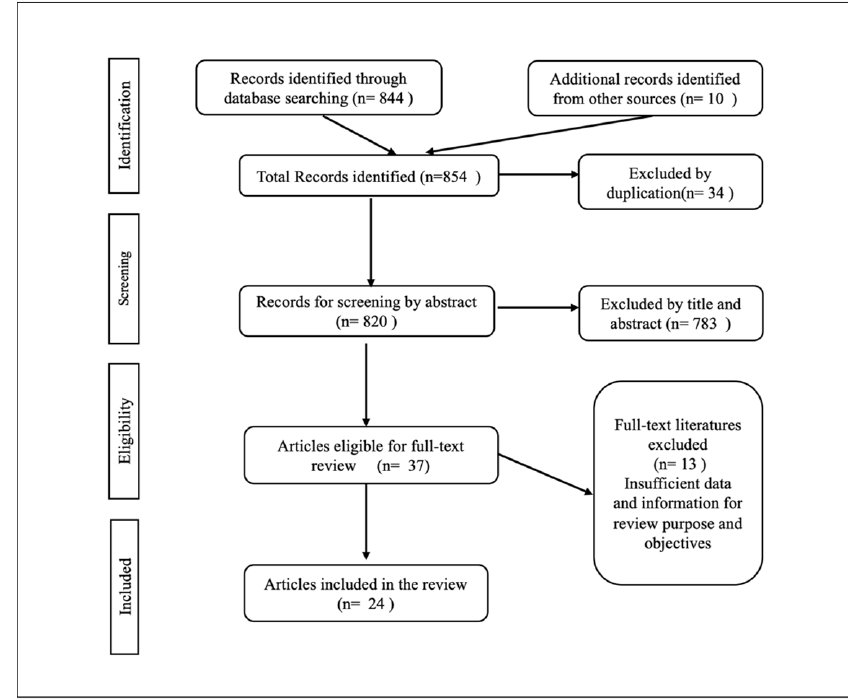
Figure 1. Study selection .